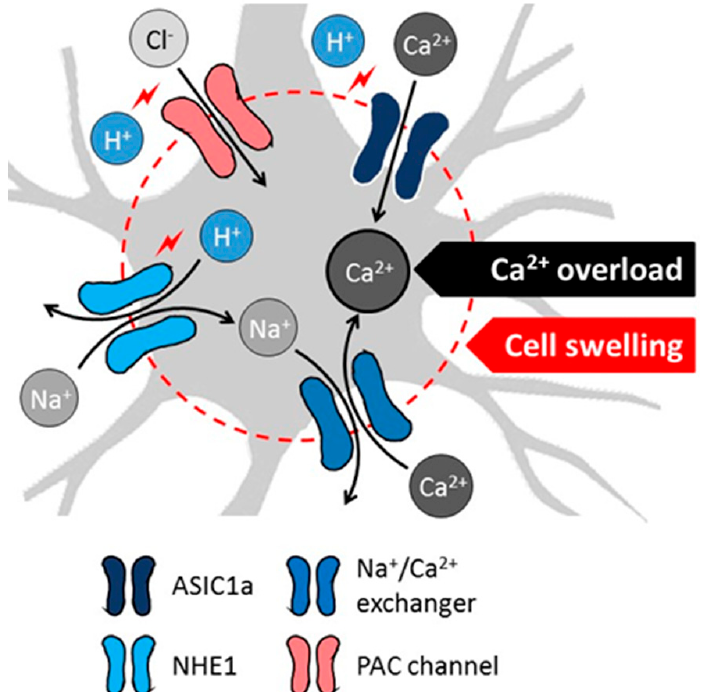
Figure 3. Proposed cellular mechanisms of acidotoxicity in ischemic stroke include acidosis-related intracellular Ca 2 + overload and swelling of neurons (schematic gray-shaded cell). Decreasing